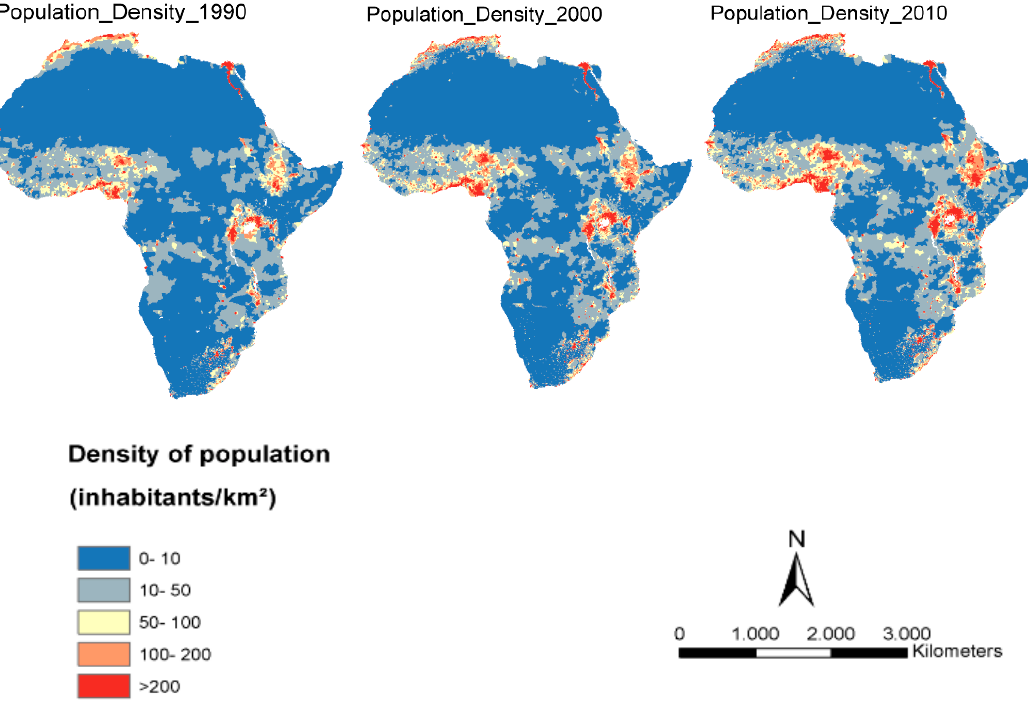
Figure 3. Rating of population density ( P ) map in Africa for 1990, 2000, and 2010.